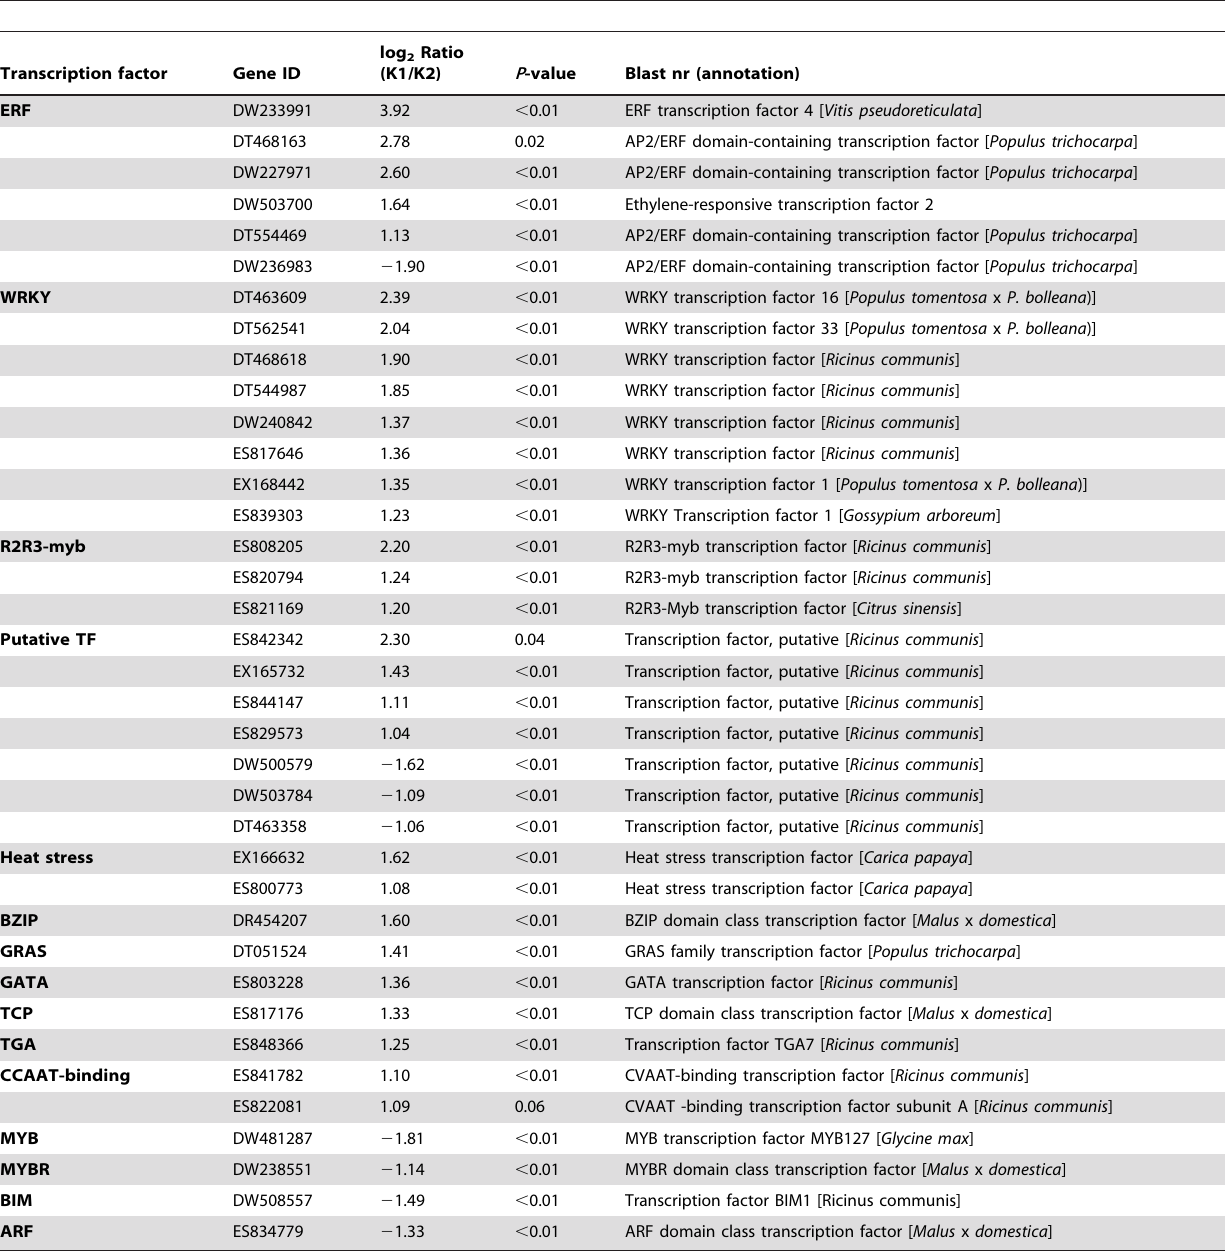
Table 4. Differently expressed transcription factor genes identified using Solexa sequencing in cotton (K1/K2).